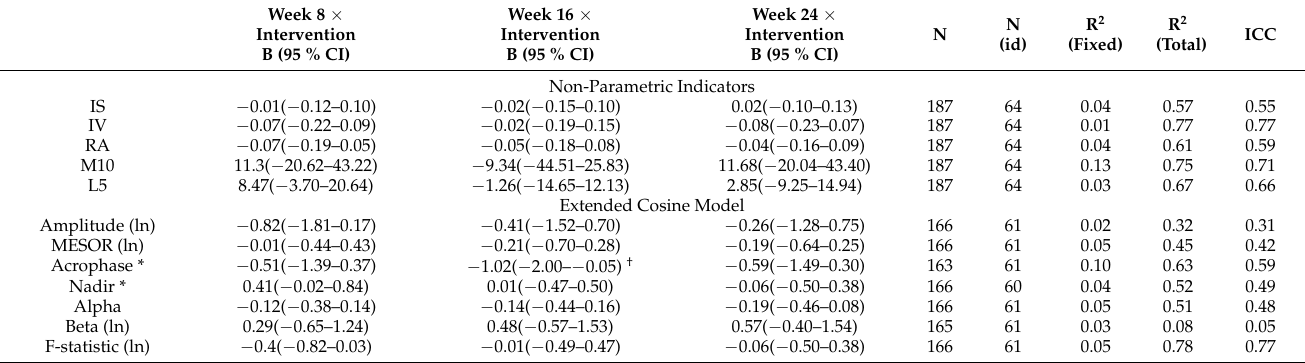
Controlling for score on the Functional Assessment Staging Test (FAST). B = regression coefficient, N = number of observations, N(id) = number of participants, R2 (fixed) = marginal R2 (i.e., the proportion of variance explained by the fixed effects alone), R2 (total) = conditional R2 (i.e., the proportion of variance explained by fixed and random factors), ICC = intraclass correlation coefficient, IS = inter-daily stability, IV = intra-daily variability, RA = relative amplitude, M10 = activity during the 10 most active hours, L5 = activity during the 5 least active hours, ln = natural logarithm. * In decimal hours. † p = 0.04 without correction for false discovery